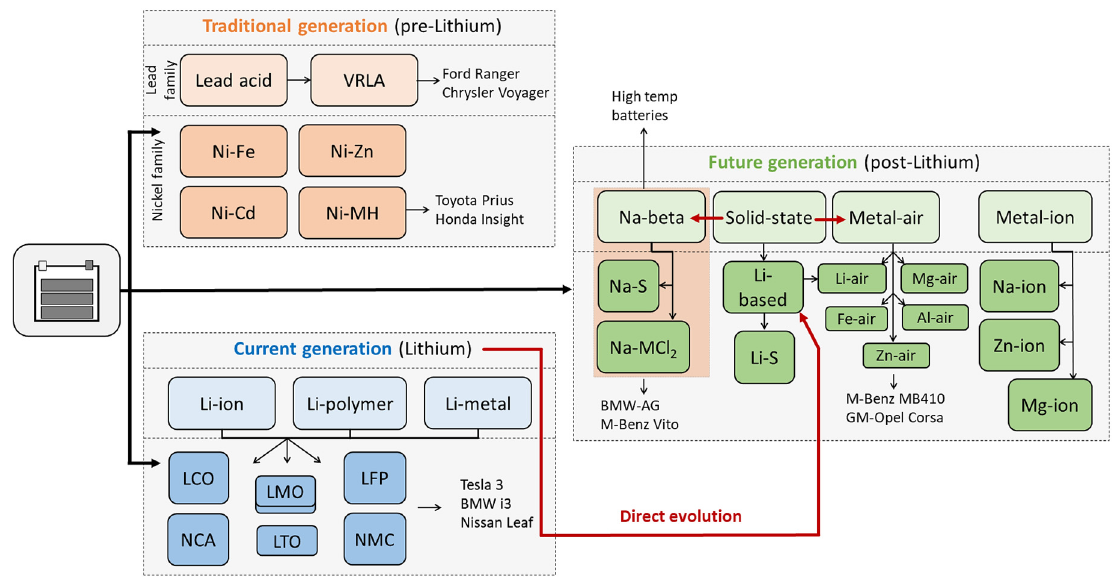
Figure 6. Generational evolution of batteries for EV applications.